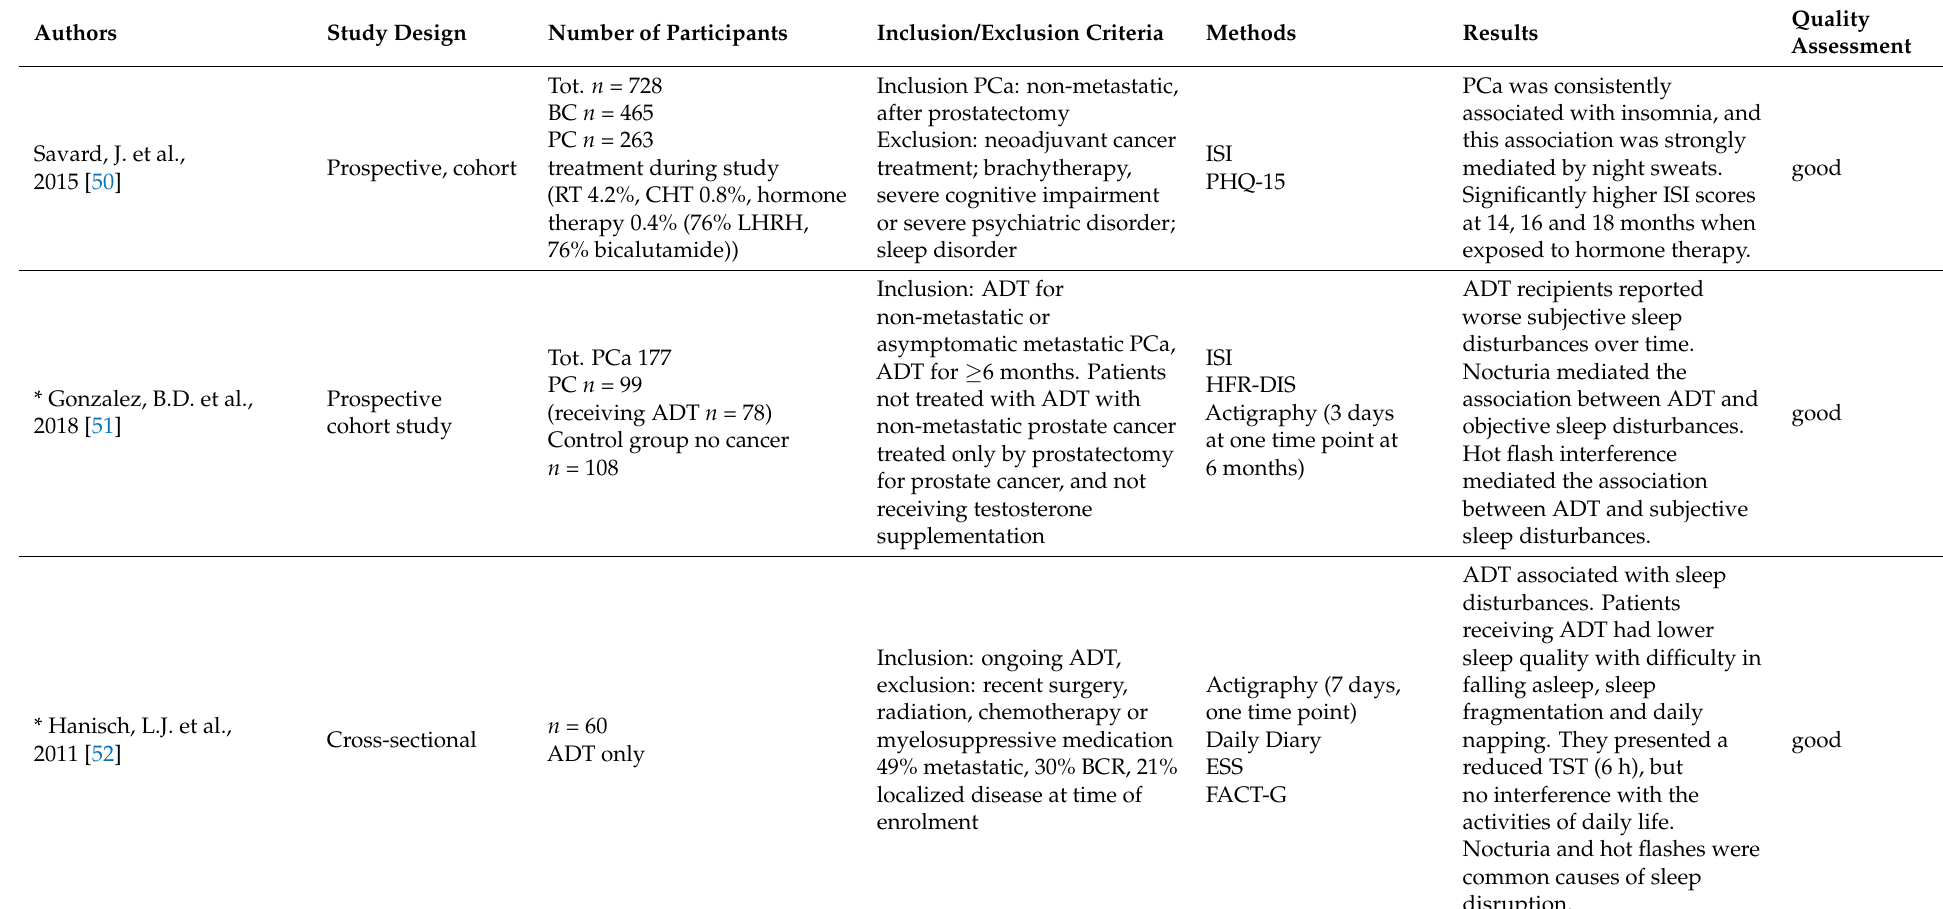
Table 1. Studies reporting on prostate cancer treatments and sleep disorders using subjective and objective